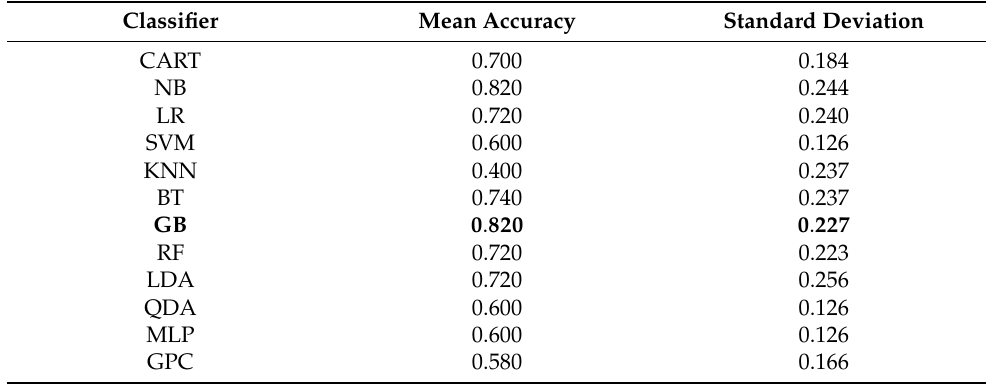
Figure 9. Cross validation results on dataset #2 for the LV level faults. Table 9. Cross validation accuracy and standard deviation for LV dataset